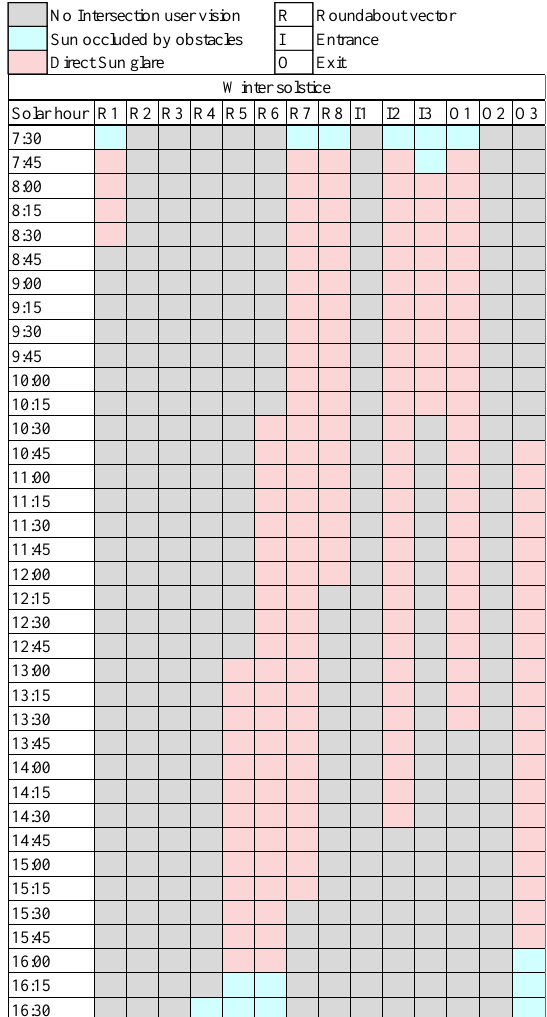
Figure 9. Sun rays incidence and intersections during winter solstice